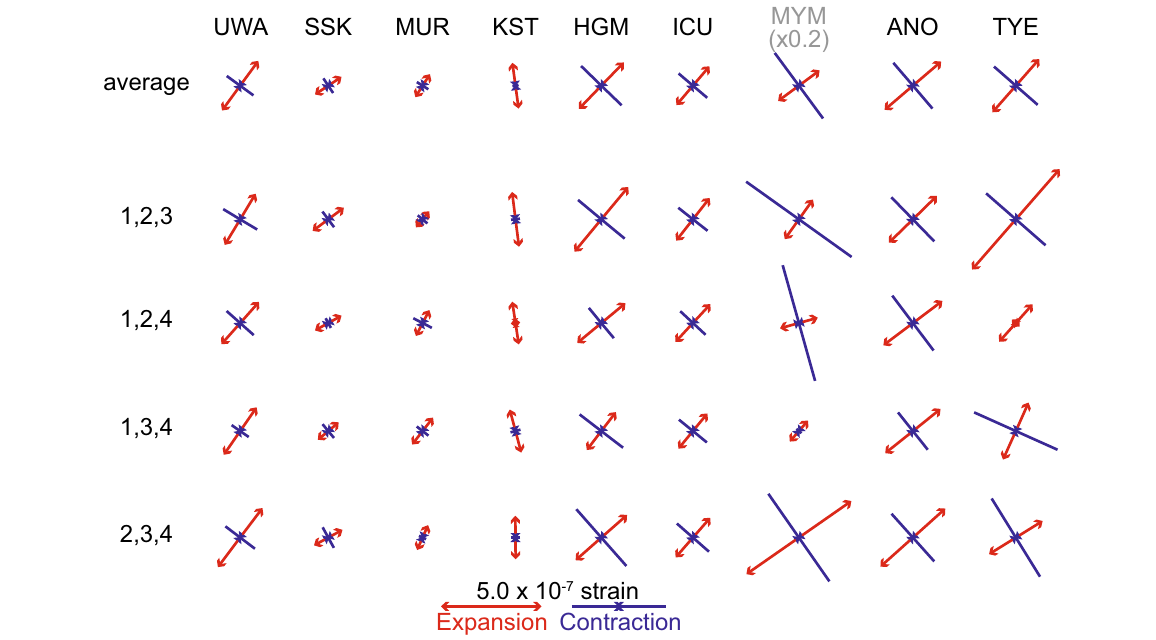
Fig. 2 Observed principal strain vectors at nine GSJ borehole stations. The four sets of principal strains are generally consistent for all stations except site MYM, for which the variation among the four sets is large owing to local noise